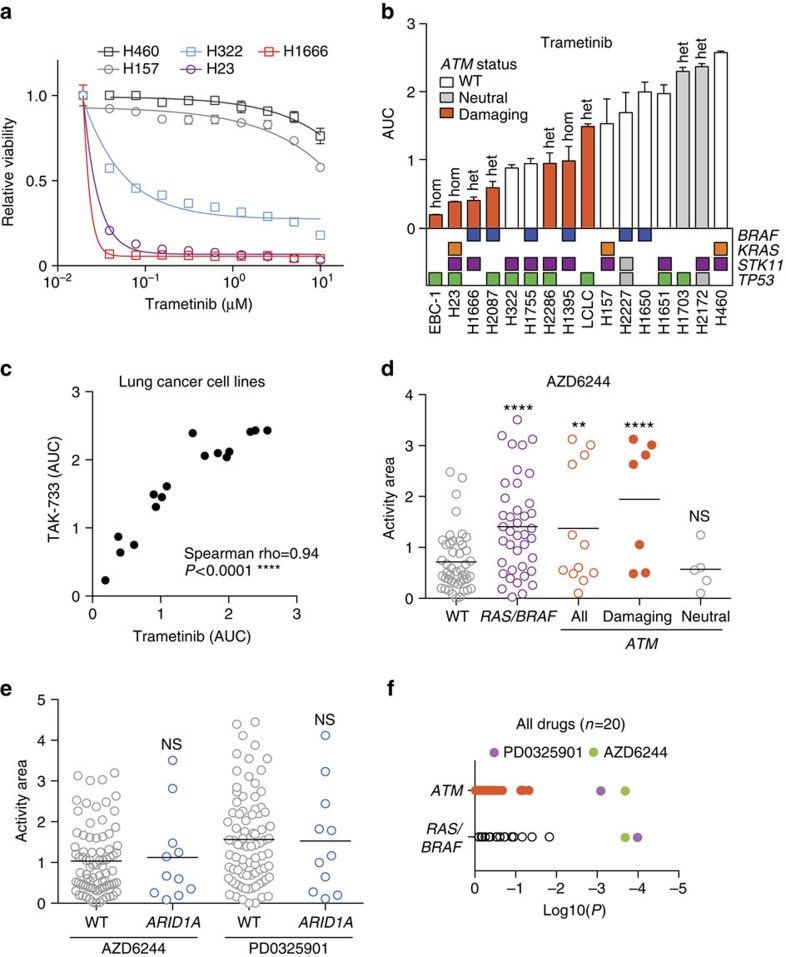
Cancer-associated ATM mutations predict MEK inhibitor sensitivity.(a) Representative dose–response curves for sensitive and resistant lung cancer cell lines treated with trametinib for 5 days and normalized to vehicle control. Error bars indicate s.d.'s (n=3). KRAS/BRAF genotypes for indicated cell lines: NCI-H460: KRAS-Q61H; NCI-H322: None; NCI-H23: KRAS-G12C; NCI-H1666: BRAF-G466V; NCI-H157: KRAS-G12R. (b) Sensitivity of indicated 16 cell lines to trametinib. Shown is the area under curve (AUC) derived from dose–response experiments as in a. When applicable, the heterozygous (het) or homozygous (hom) mutational status of ATM is indicated above the bars and mutational status for selected genes is indicated below. Error bars indicate s.d.'s (n=3). (c) Area under curve values derived from dose–response experiments with TAK-733 and trametinib for 16 lung cancer cell lines. (d) Sensitivity of lung cancer cell lines in the Cancer Cell Line Encyclopedia (CCLE) to the MEK inhibitor AZD6244 (selumetinib). High activity area score (area above the curve24=AAS) indicates drug sensitivity. Each circle indicates a single cell line and cell lines are grouped according to genotype (WT=wild type for K-Ras, H-Ras, N-Ras, BRAF, c-RAF and ATM; ATM=ATM mutant; RAS=K-Ras, H-Ras or N-Ras mutant). ATM mutations are labelled according to PolyPhen predictions (damaging >0.9, neutral <0.9). Black bar indicates mean AAS. **P<0.01, ****P<0.0001, NS=not significant, two-sided t-test compared with WT group. (e) Analysis as in d for ARID1A mutant or wild-type cell lines for sensitivity to indicated MEK inhibitors. NS=not significant, two-sided t-test. (f) Analysis of ATM or RAS/BRAF mutant cell lines for response to drugs (n=20) in CCLE data set. Indicated is the P value for each drug.